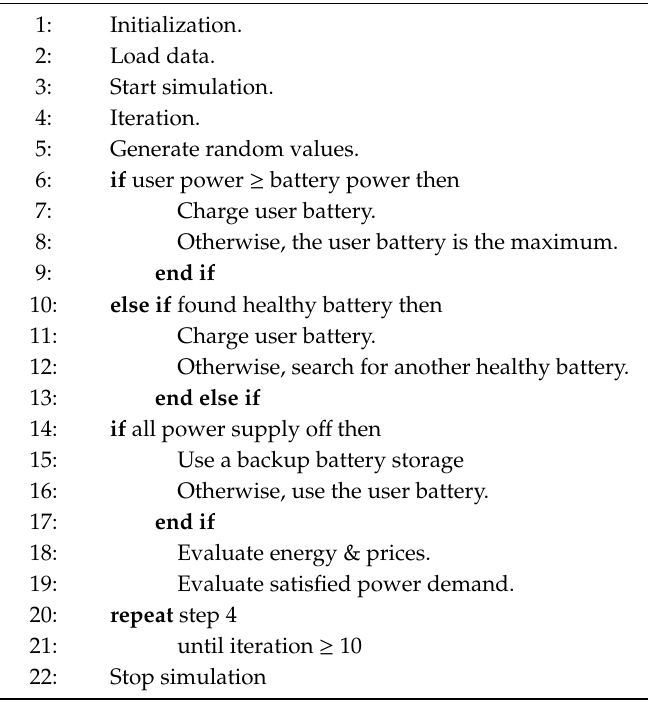
Algorithm A1: Power-Sharing Algorithm